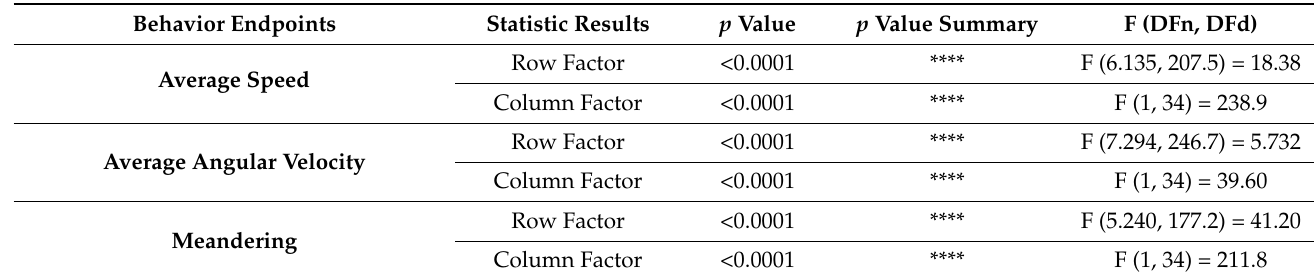
Table A2. Summary of statistic results of each fish behavioral endpoint in the 3D locomotion test from Figure 4. The data were analyzed by mixed models two-way ANOVA continued with Sidak’s multiple comparisons test (rows = time, column = fish group; ns = not statistically significant, ** p < 0.01, *** p < 0.001, **** p <